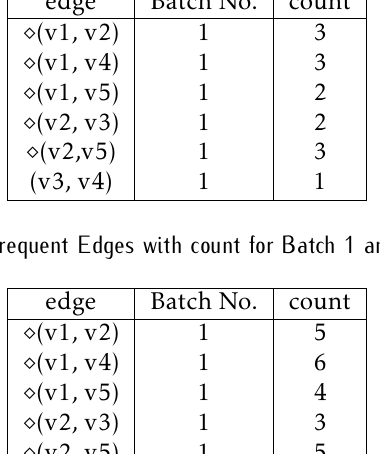
Table 7. Frequent Edges with count for Batch 1 edge Batch No.